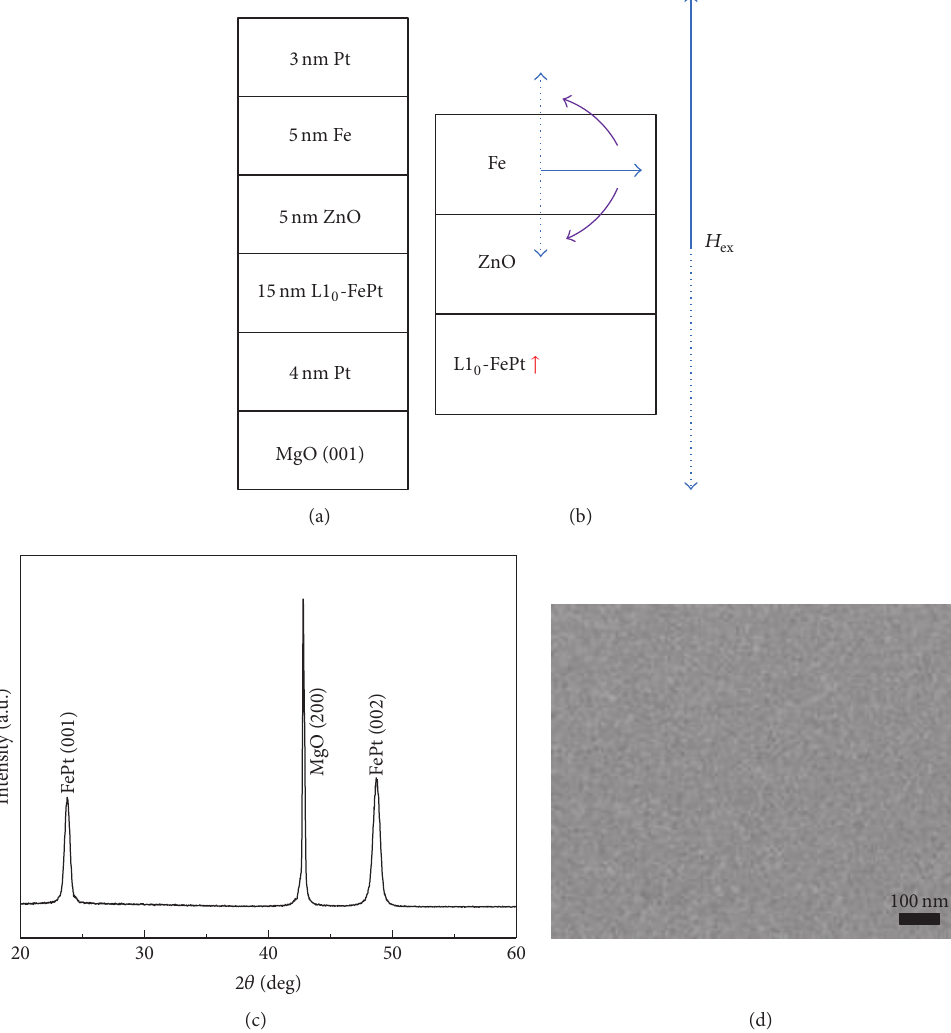
Figure 1: (a) Schematics of the Pt(4)/FePt(15)/ZnO(5)/Fe(5)/Pt(3) multilayers on MgO substrate; (b) the core sandwich schematic diagram of L1 0 -FePt/ZnO/Fe. The magnetization directions are marked by arrows, and the applied external magnetic field is perpendicular to the film plane; (c) XRD spectra of the Pt(4)/L1 0 -FePt(15) bilayer films; (d) SEM image of the Pt(4)/L1 0 -FePt(15) bilayer film